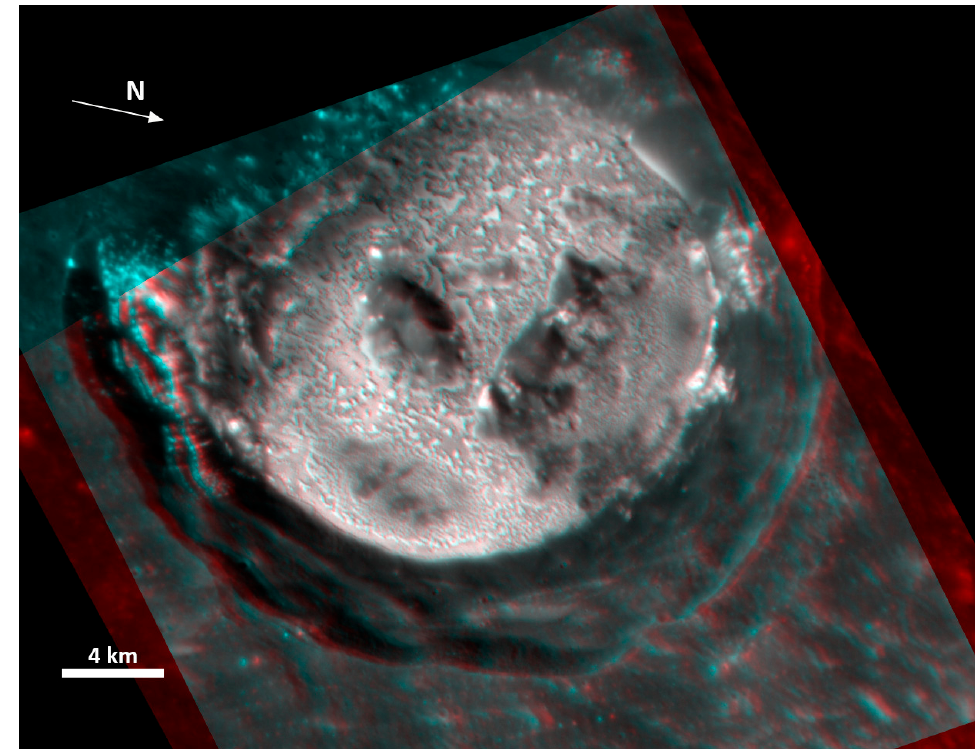
Figure A10. Kertész Crater. Images: EN1010096377M, EN1010096528M. Figure A10. Kert é sz Crater. Images: EN1010096377M,